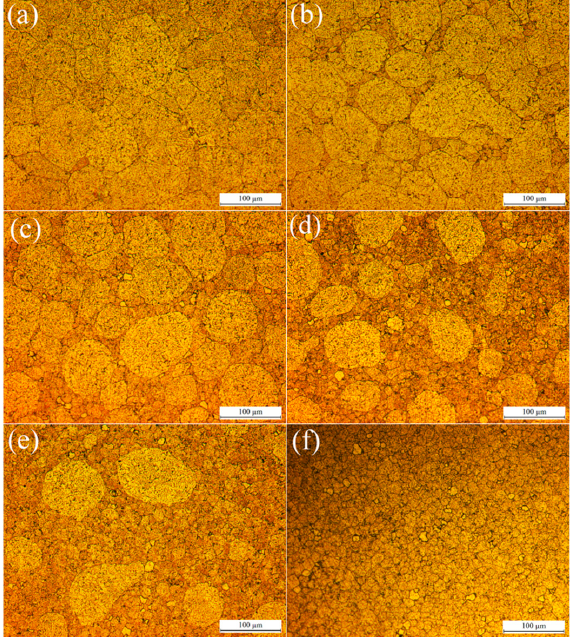
Figure 2. Typical metallographic images of sintered 7075 alloys, ( a ) AL1, ( b ) AL2, ( c ) AL3, ( d ) AL4, ( e ) AL5, and ( f ) AL6.